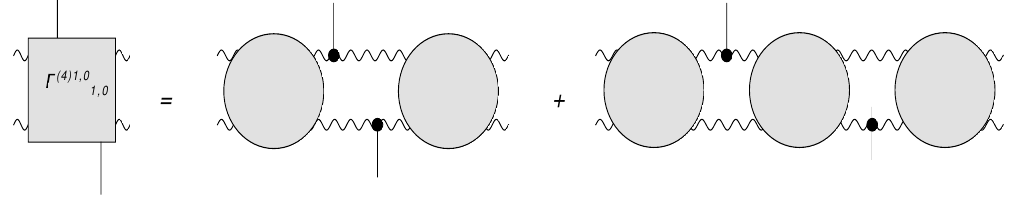
Figure 17 . Identity for the 6-point